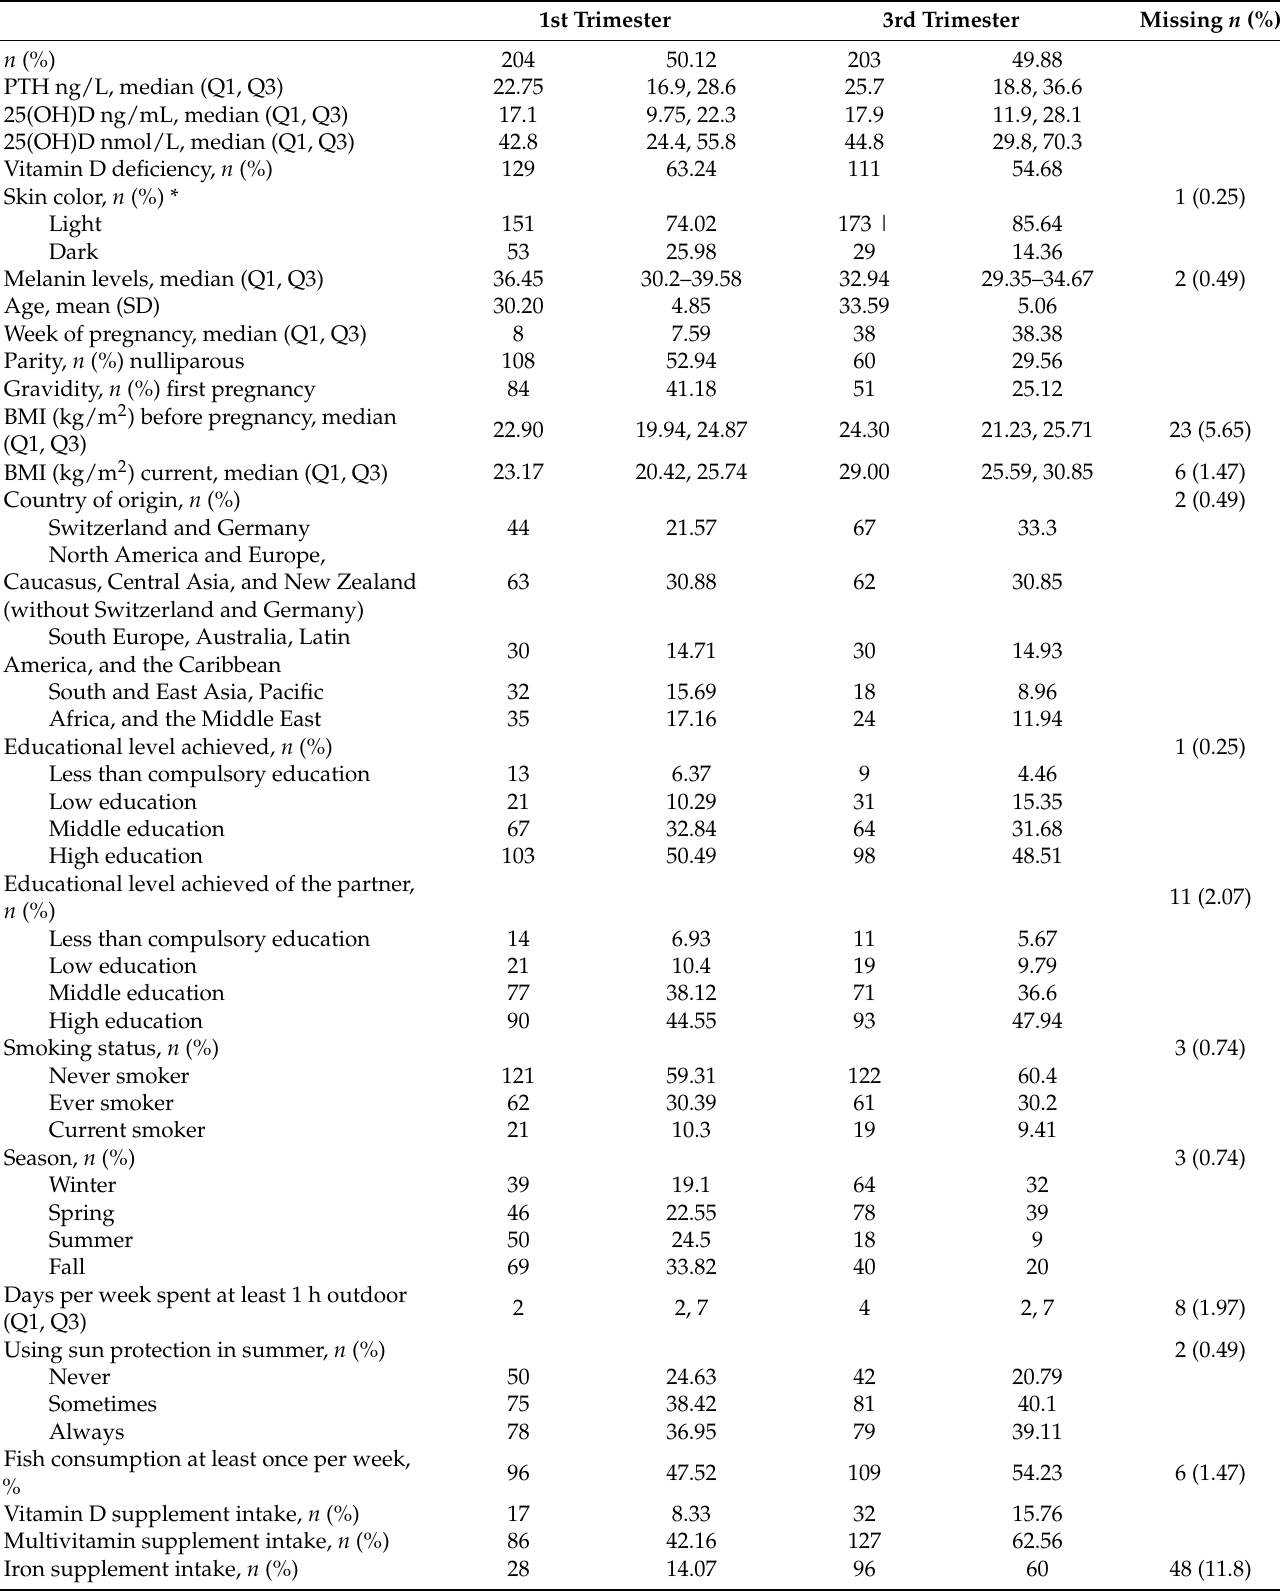
Table 1. General characteristics of pregnant women in first and third trimesters of